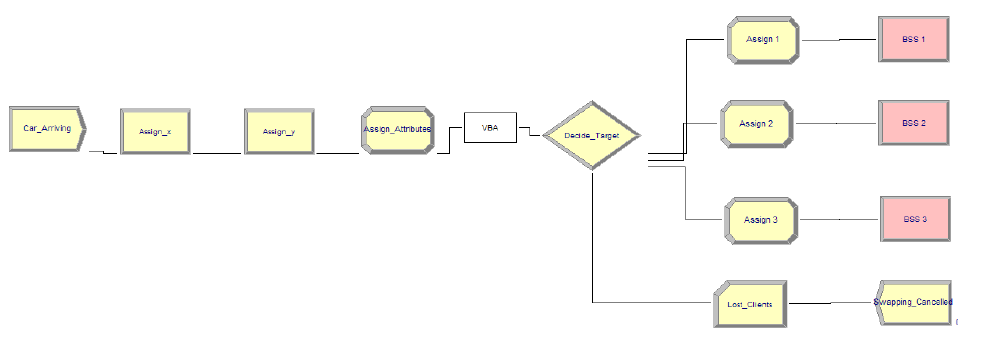
Figure 14. Flow chart showing user decision